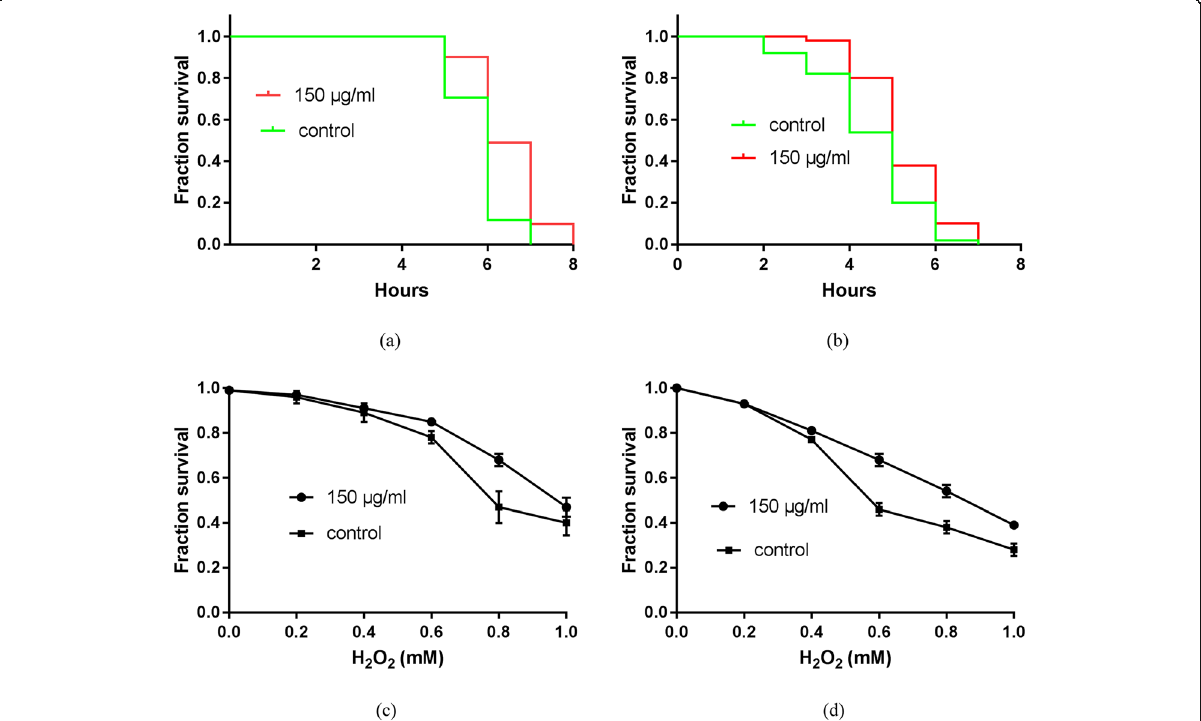
Fig. 2 The effect of JPYW on stress resistance in C. elegans N2 worms. a Heat stress resistance in wild-type larvae. Wild-type worms that were incubated at a constant temperature (37 °C ) were pretreated with 150 μ g/ml JPYW or vehicle control (1% DMSO). Survival was assessed every hour after heat stress treatment. JPYW significantly prolonged the lifespan of wild-type worms under heat stress compared to the vehicle control (n = 50 – 55, P < 0.05). b Heat stress resistance in aged C. elegans N2 worms. Aged worms that were incubated at a constant temperature (37 °C ) were pretreated with 150 μ g/ml JPYW or vehicle control (1% DMSO). Survival was assessed every hour after heat stress treatment. JPYW treatment significantly prolonged the lifespan of aged wild-type worms under heat stress compared to the control treatment (n = 50 – 55, P < 0.05). c Oxidative stress resistance in C. elegans N2 worms. Wild-type worms were pretreated with 150 μ g/ml JPYW or vehicle control (1% DMSO) and were exposed to various concentrations of hydrogen peroxide (0, 0.2, 0.4, 0.6, 0.8, and 1 mM). Survival was assessed after 15 h of each treatment. d Oxidative stress resistance in aged C. elegans N2 worms. Aged worms were pretreated with 150 μ g/ml JPYW or vehicle control (1% DMSO) and were exposed to various concentrations of hydrogen peroxide (0, 0.2, 0.4, 0.6, 0.8, and 1 mM). Survival was assessed after 15 h of each